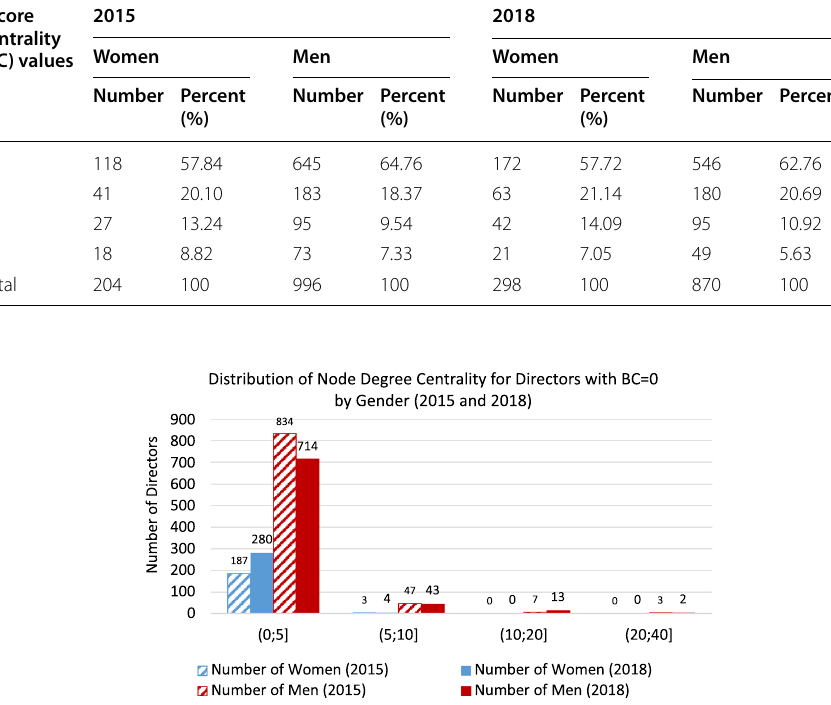
Fig. 7 Distribution of Node Degree Centrality for Directors with BC